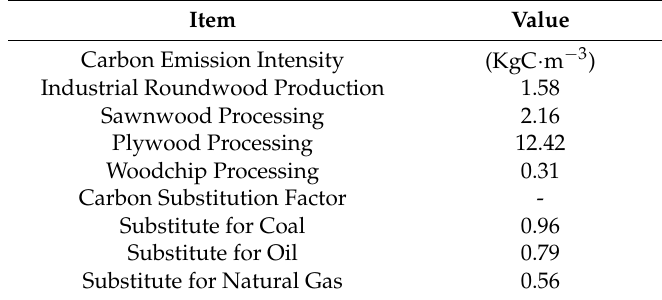
Table A2. Carbon emission intensity and substitution factor for HWP carbon balance